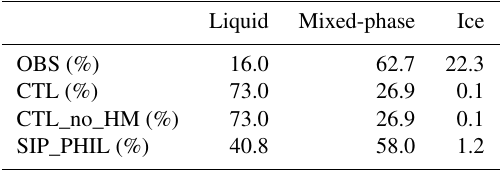
Figure 9. Liquid fraction as a function of normalized cloud height from cloud base. The normalized cloud altitude Z n is defined as Z n = (z − Z b )/(Z t − Z b ) , in which z is the altitude, Z b is the alti- tude of cloud base, and Z t is the altitude of cloud top, from (a) ob- servations, (b) CTL, (c) SIP_PHIL, and (d) CTL_no_HM. Table 3. Percentage of occurrence of liquid, mixed-phase, and ice clouds during single layer mixed-phase clouds from observations (OBS) and CTL, CTL_no_HM, and SIP_PHIL